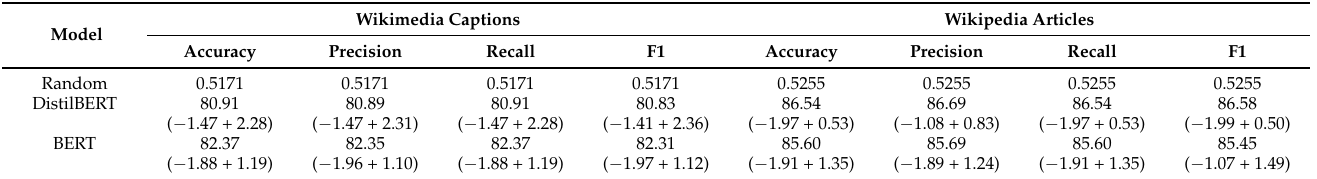
Table 3. Results comparing the informativeness of the proposed dataset.